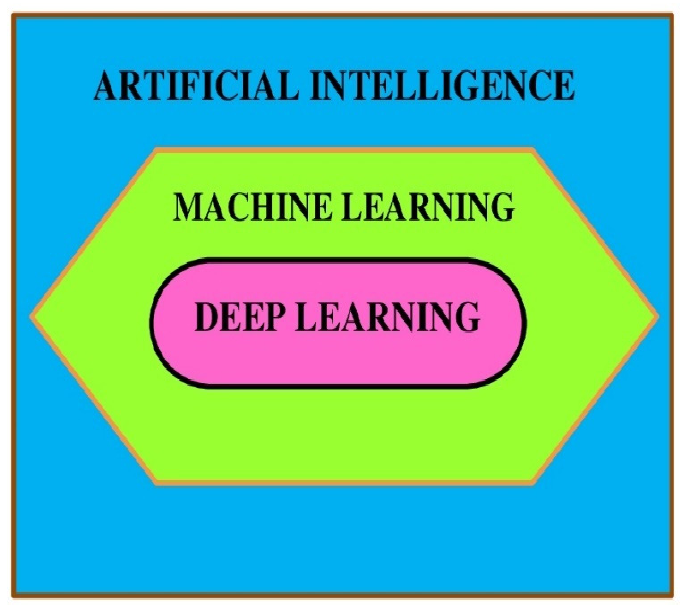
Figure 5. Relationship between AI, ML, and DL.